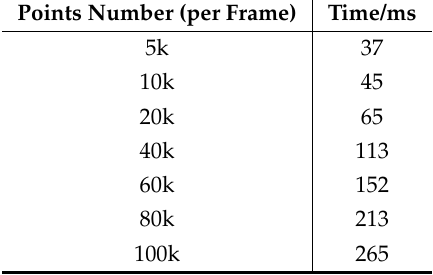
Table 5. Voxel size is 0.1